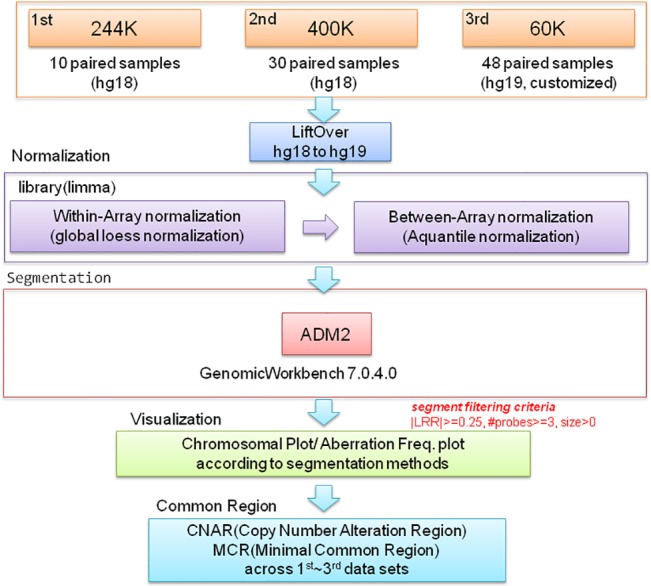
A schematic diagram for identifying a minimal common region.The Aberration Detection Method 2 (ADM-2) algorithm with a sensitivity threshold of 6.0 was used to identify the CNAs in gastric cancer and to determine the frequencies of CNAs in each sample. The MCR (Minimal Common Region) of copy number gains or losses was identified through the analysis of CNAs in the three kinds of aCGHs (244K, 400K, and 60K).